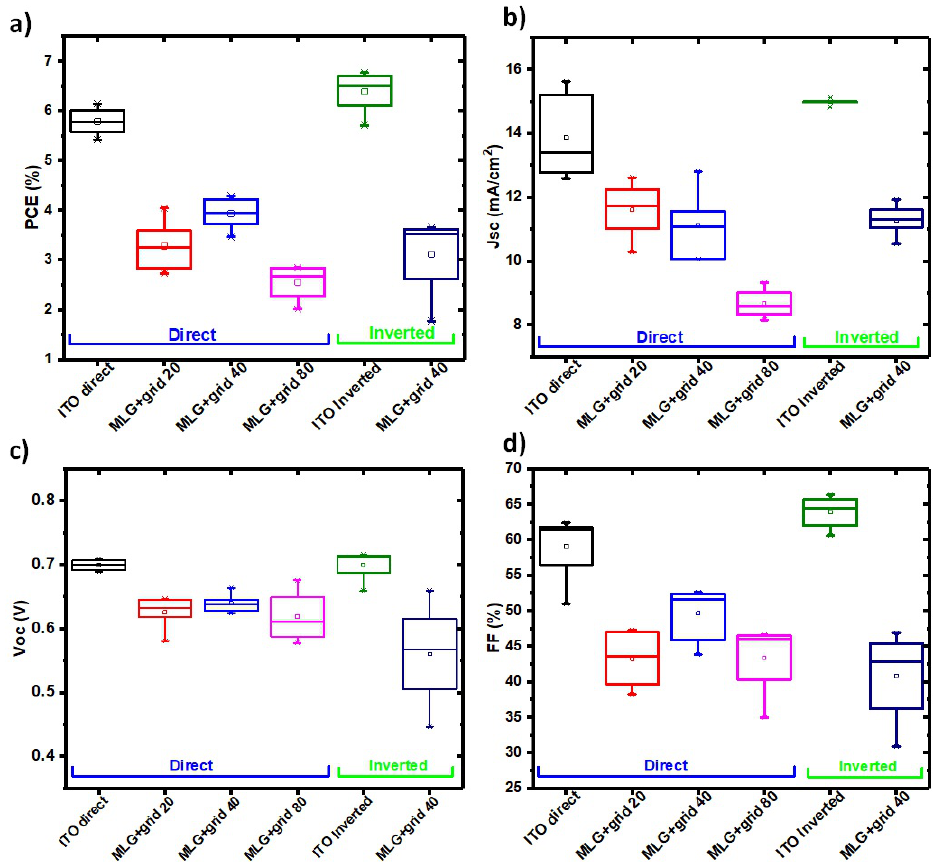
Figure 5. tatistics of the J-V characteristics of the BHJ-SCs realized with direct and inverted architecture: ( a ) efficiency, ( b ) short circuit current, ( c ) open circuit voltage, ( d ) fill factor. Two different anodes have been tested: ITO/glass, and Graphene/Ni-grid on quartz. For the direct architecture different grid thicknesses have been tested (20 nm, 40 nm, 80 nm), for the inverted architecture only optimized thickness of 40 nm has been used.